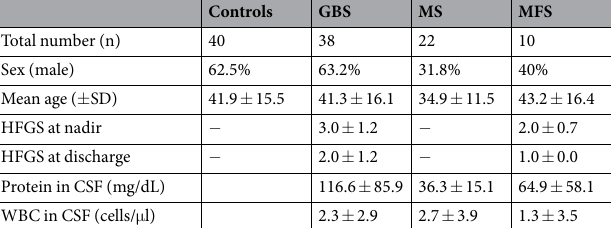
Table 1. Basal demographics of GBS, MS and MF patients, and healthy controls. Abbreviations: GBS, Guillain- Barre syndrome; MS, Multiple sclerosis; HFGS, Hughes functional grading scale; WBC, white blood